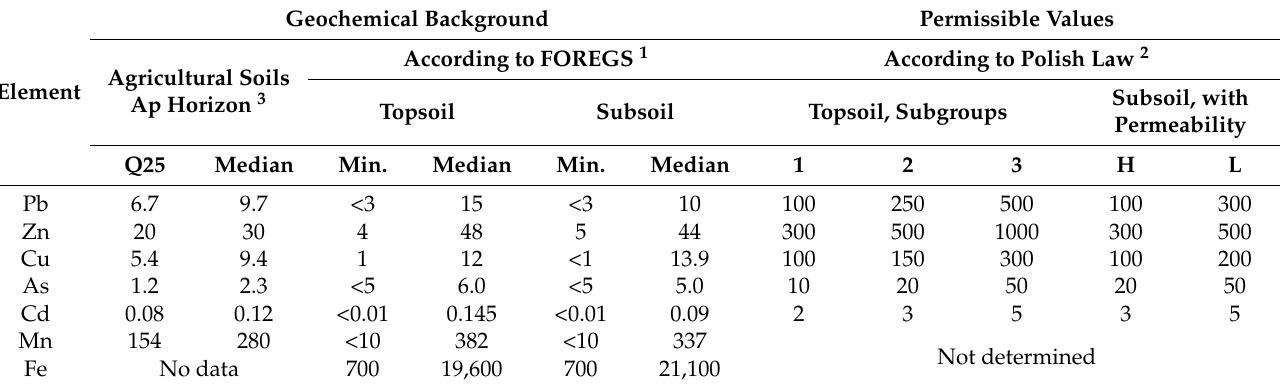
(Table 3), i.e., the median values for European subsoil, according to FOREGS [51,52]. Table 3. Reference concentrations of metal(loid)s in soils according to various